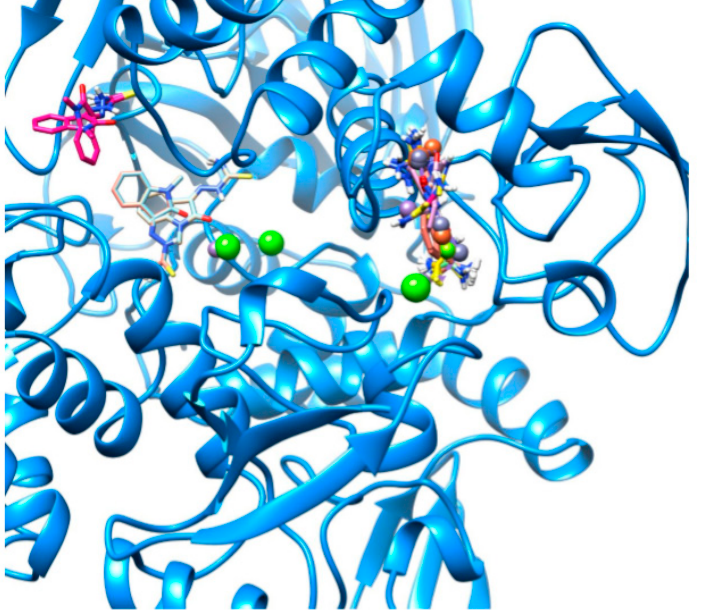
Figure 2. Visualization of high-energy docking sites in 6W9C. Three different absorption sites are evident. Free Methisazone and its metal complexes appear to dock in different pockets. The most populated site accommodates all metal complexes, the second most populated holds two metal complexes, and the third is occupied only by free Methisazone. Molecular graphics and analyses performed with UCSF Chimera, developed by the Resource for Biocomputing, Visualization, and Informatics at the University of California, San Francisco, with support from NIH